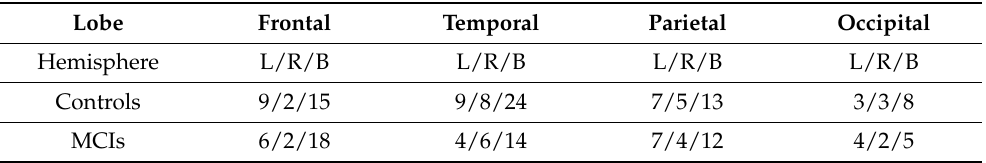
Table 7. The intra-lobular connectivity and connectivity ratios (MCI/controls) of four cerebral lobes for the control and MCI groups. * p < 0.05.